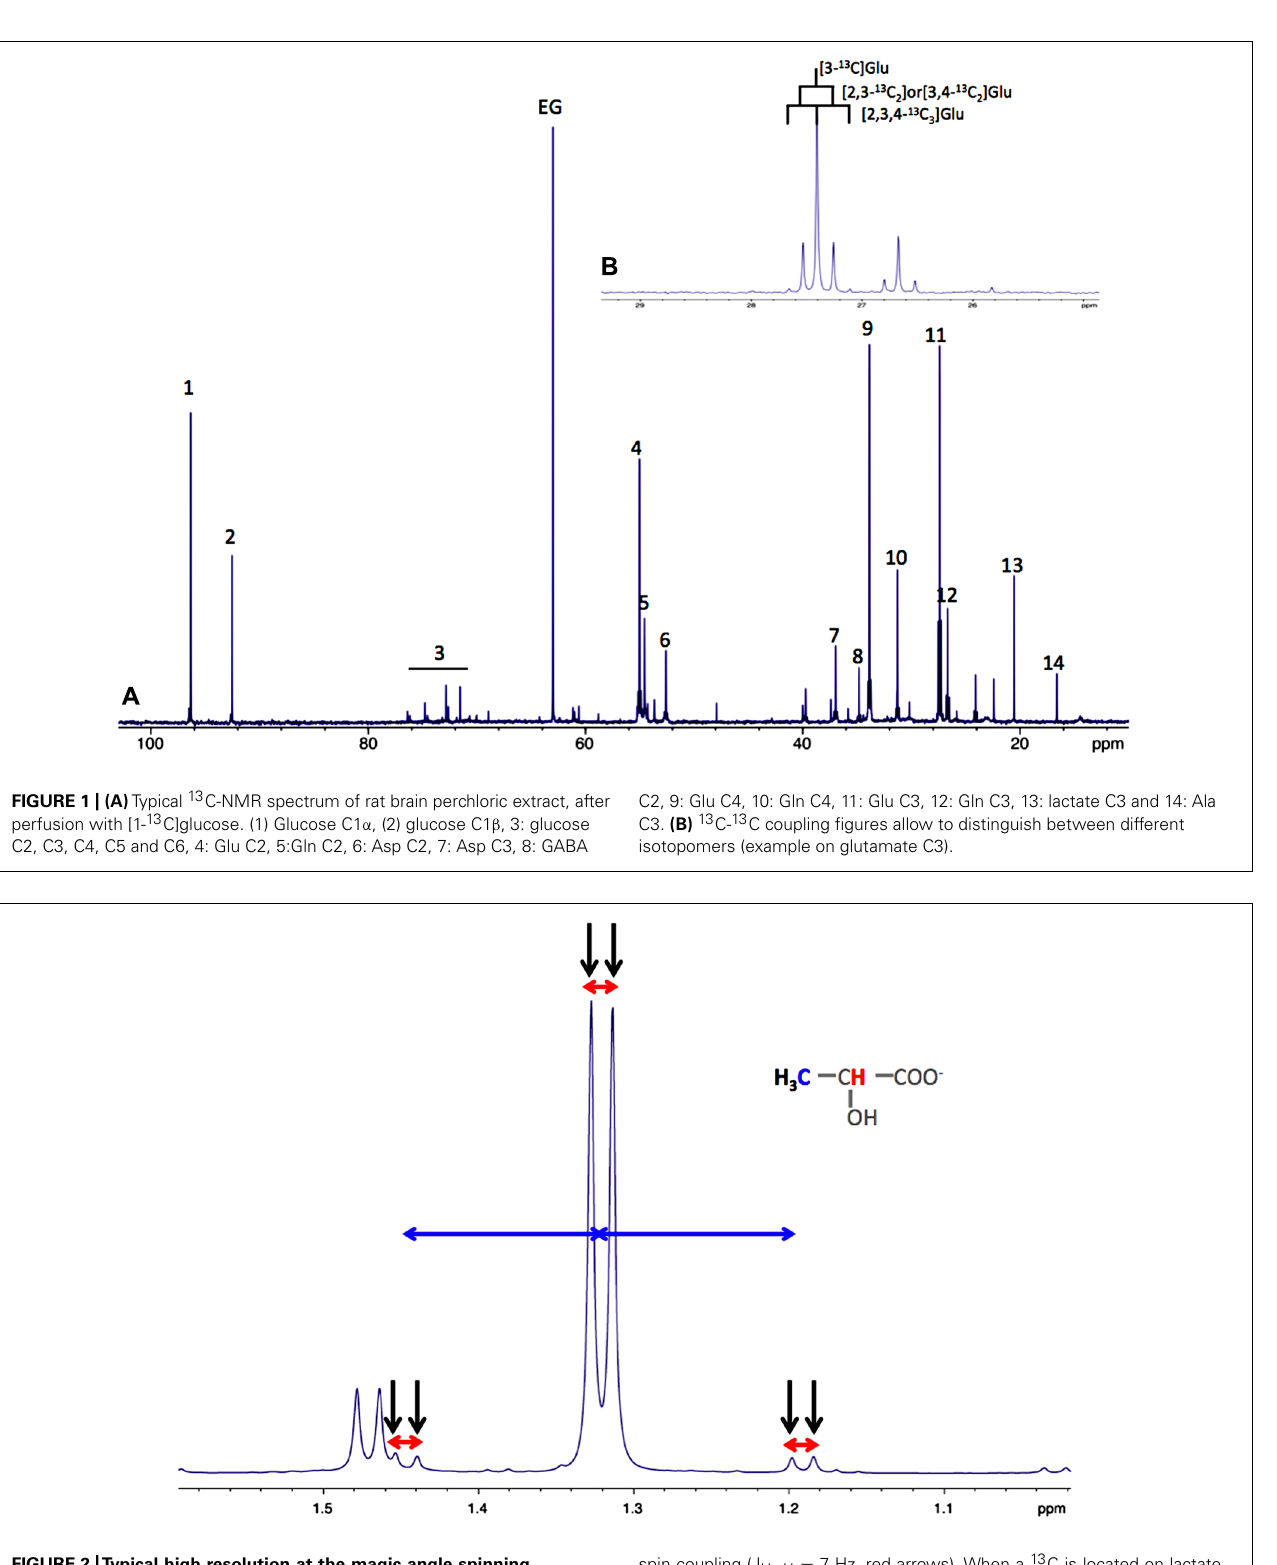
FIGURE 2 |Typical high resolution at the magic angle spinning (HRMAS) 1 H-NMR spectrum of rat brain biopsy after [3- 13 C]lactate perfusion. Protons of the methyl group of lactate are detected (black arrows), centered at 1.32 ppm.The doublet is coming from the homonuclear